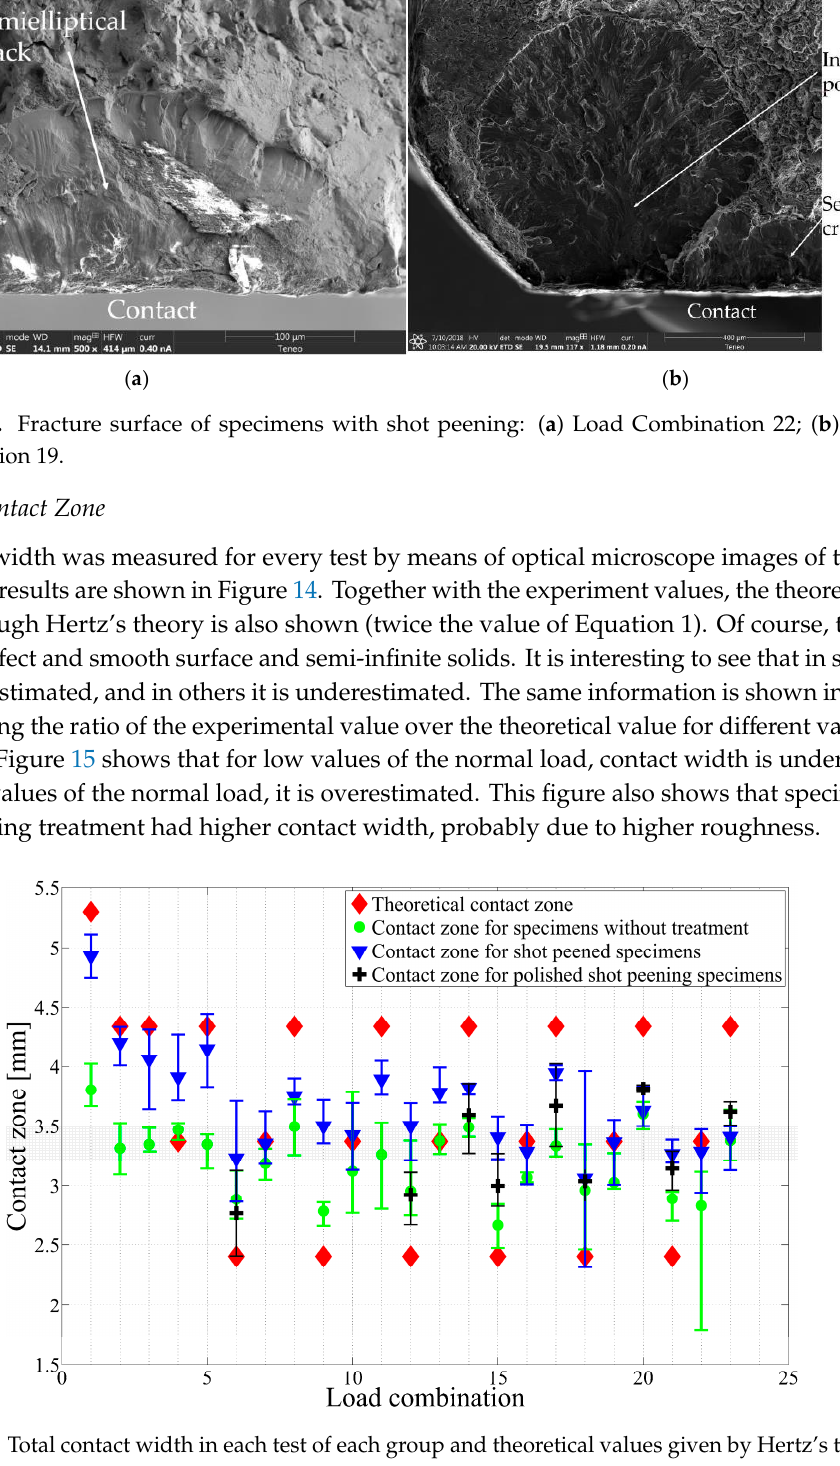
Figure 15. Ratio of experimental and theoretical contact size. 4. Cyclic Relaxation of Residual Stress When used as a palliative against fatigue, an important aspect of residual stress is its stability. Cyclic loads, even those producing stresses below the yield limit, are known to relax the residual- stress field [53,54]. To quantify relaxation in the present experimental campaign, a series of interrupted fretting-fatigue tests were performed. Next, after the required load cycles, test specimens were withdrawn from the testing device in order to measure actual residual stress. Once the residual stress is measured after the target number of cycles, the test specimen cannot be tested again because the contact zone is destroyed during the measurement, so every measurement corresponds to a different test specimen. Measurements were made in a place very close to the right edge of the contact zone (contact trailing edge) but always inside the slip zone (see Figure 16), which is the place where fretting-fatigue cracks are experimentally found and where stresses are higher.